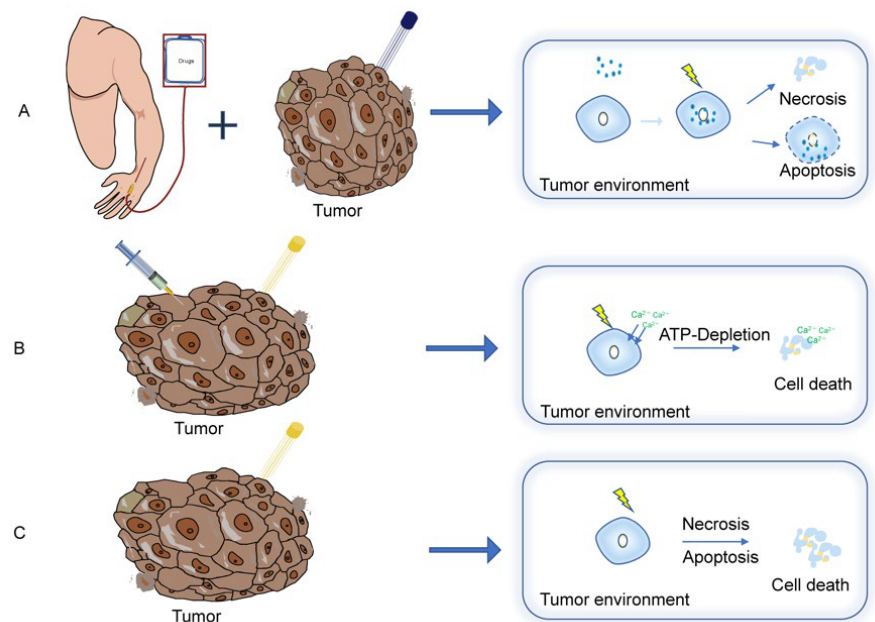
Figure 2. Schematics of electroporation-related therapies. ( A ) Electrochemotherapy; ( B ) calcium electroporation; ( C ) irreversible electroporation.